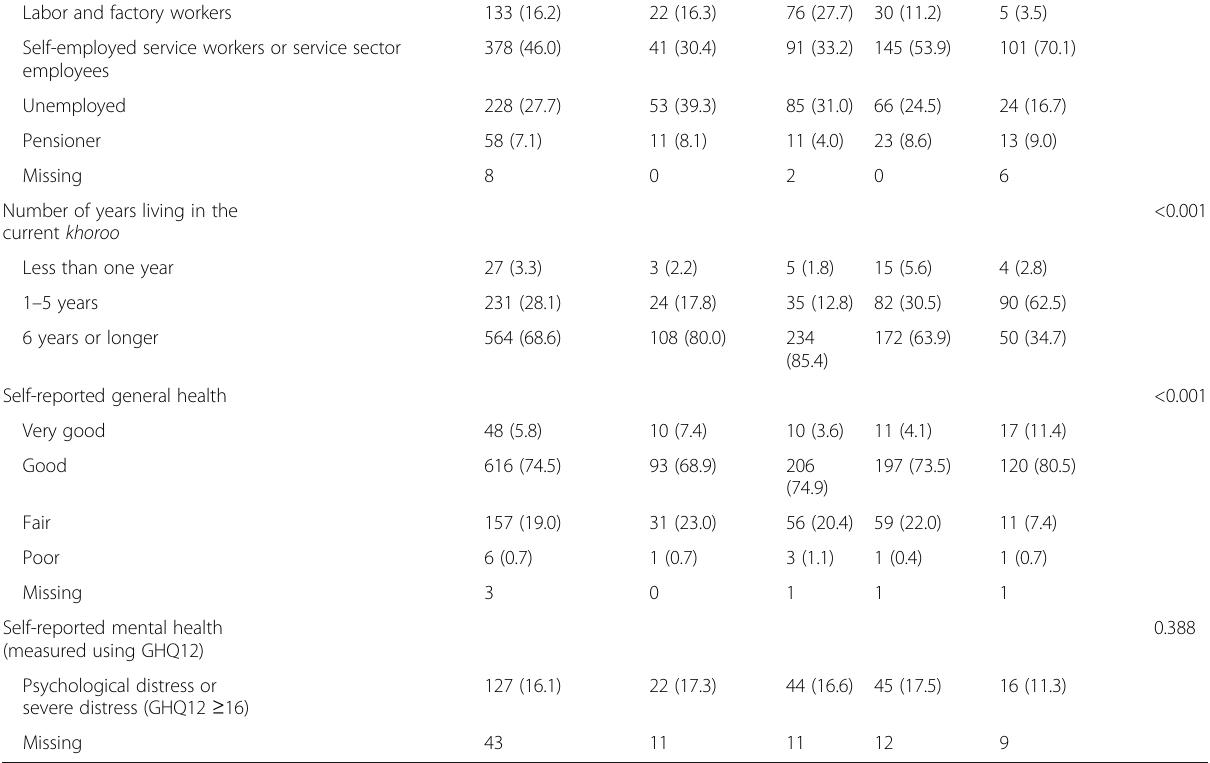
Table 1 Demographic and socio-economic characteristics and health status of the subjects according to residential area (Continued) Labor and factory